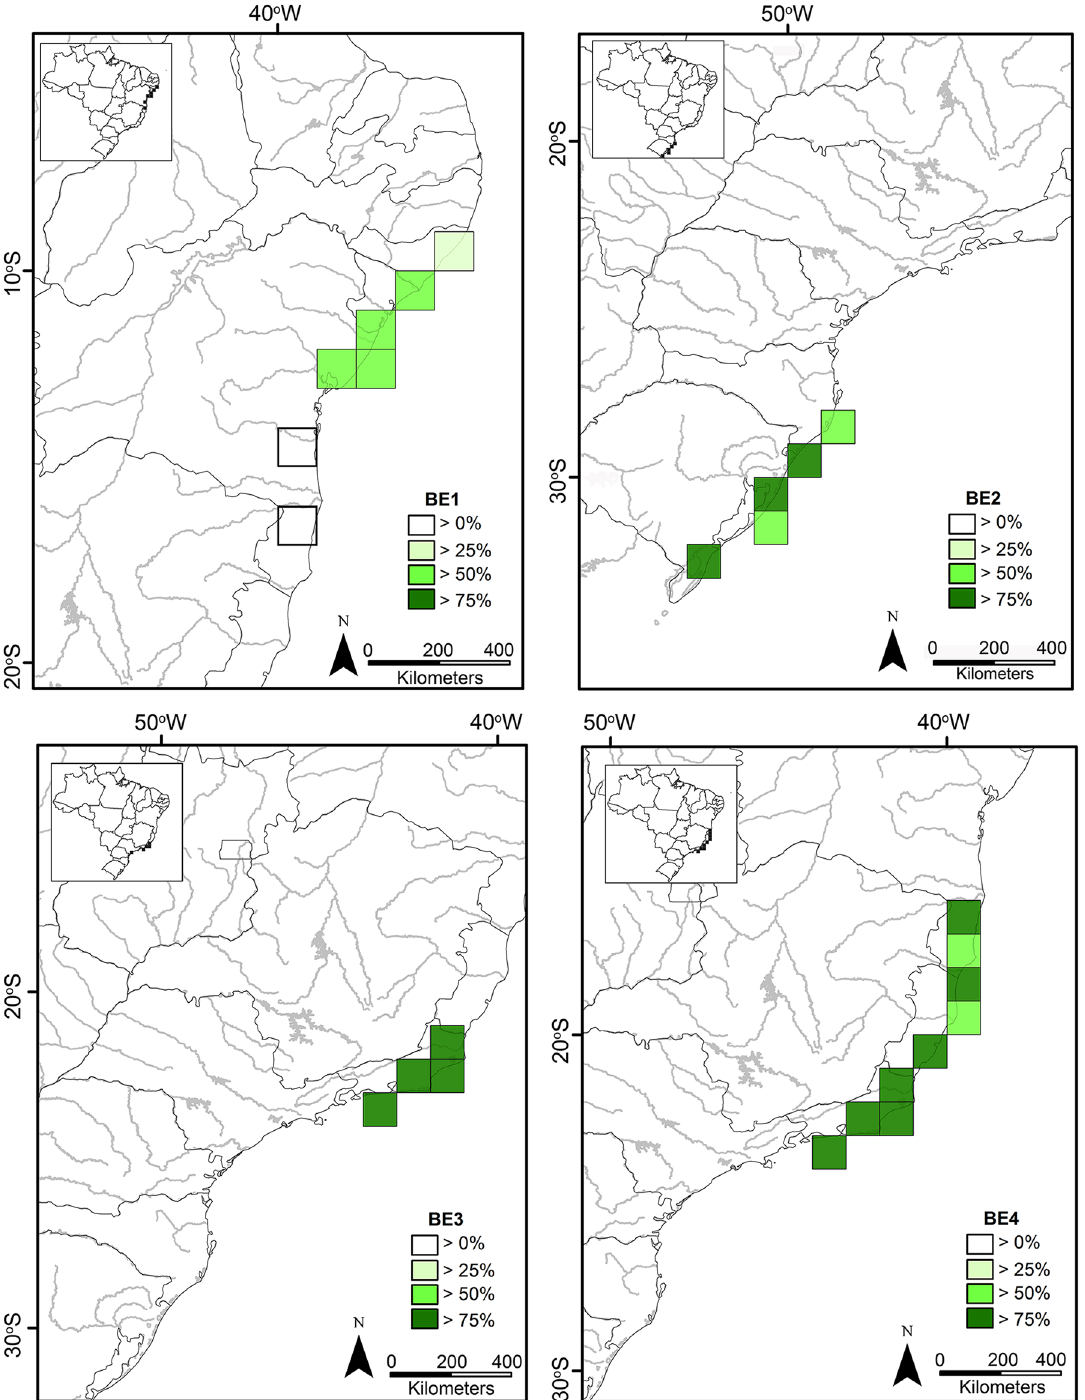
Fig 5. Distribution of the biotic elements (BE) recovered according to the range of 63 anuran species from the Restingas. Each biotic element is comprised by the respective set of quadrats. Shadings indicate the areas where > 75% (= core area), > 50%, > 25% and > 0% of the species of an element are